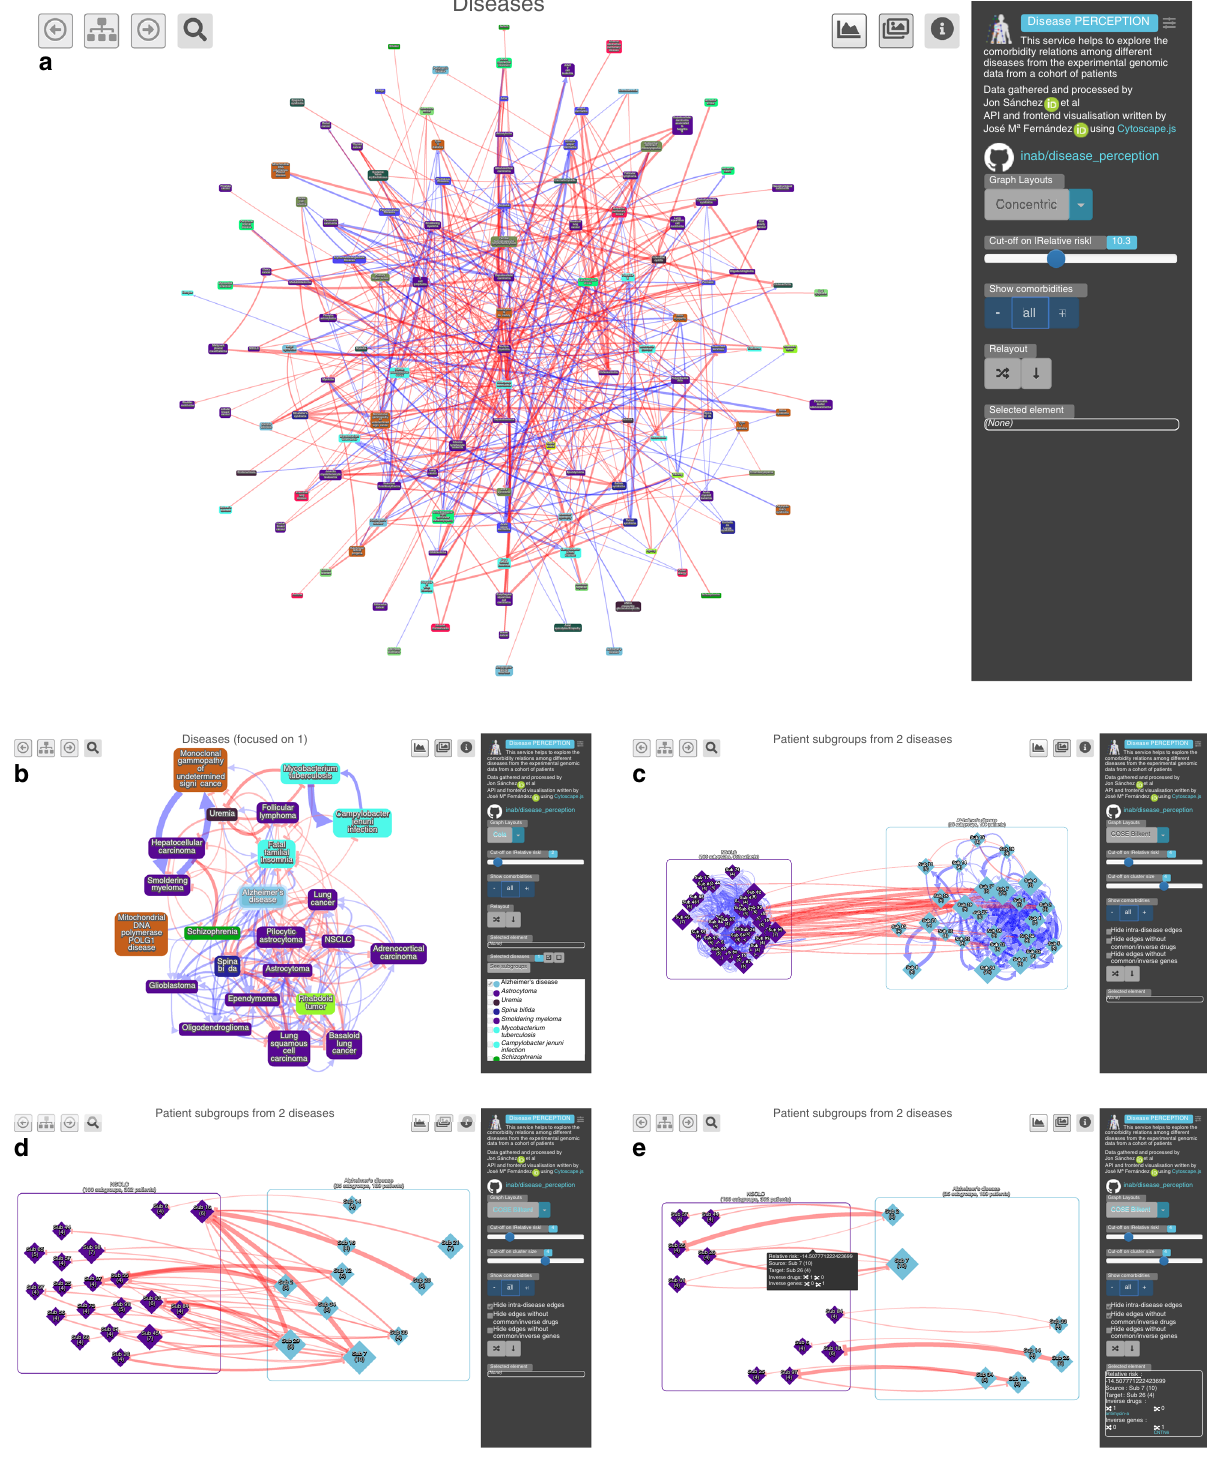
Fig. 7 The Disease PERCEPTION portal. Through this user-friendly and programmatically accessible portal, the user can visualize comorbidity relations at the disease and patient-subgroup levels. Moreover, users can extract patient-subgroup information, fi ltering by subgroup size, intra-subgroup connectivity, as well as by shared drugs and/or genes. Genes and drugs in the networks are hyperlinked to databases, facilitating an interactive exploration of the molecular basis of each connection. a Disease network view. Each node represents a disease, colored based on the disease category it belongs to. Blue and red edges denote positive and negative Relative Molecular Similarity (pRMS, nRMS) interactions. Relative risk cut-off can be modi fi ed. b AD neighbors view. Desired diseases can be selected to show their patient-subgroups. c AD and NSCLC patient-subgroups with >4 patients per subgroup. d Same as c excluding intra-disease interactions. e Same as c showing only patient-subgroup interactions with shared drugs. Selecting edges of interest displays genes and drugs potentially involved in the selected